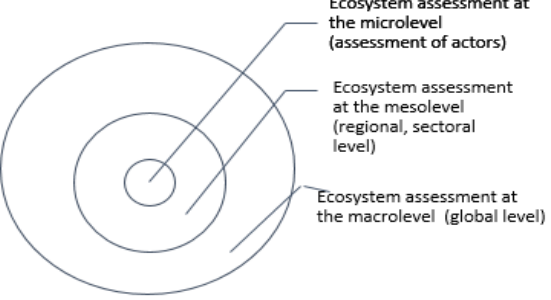
Figure 2. Approaches to assessing entrepreneurial ecosystems. Source: Own elaboration.